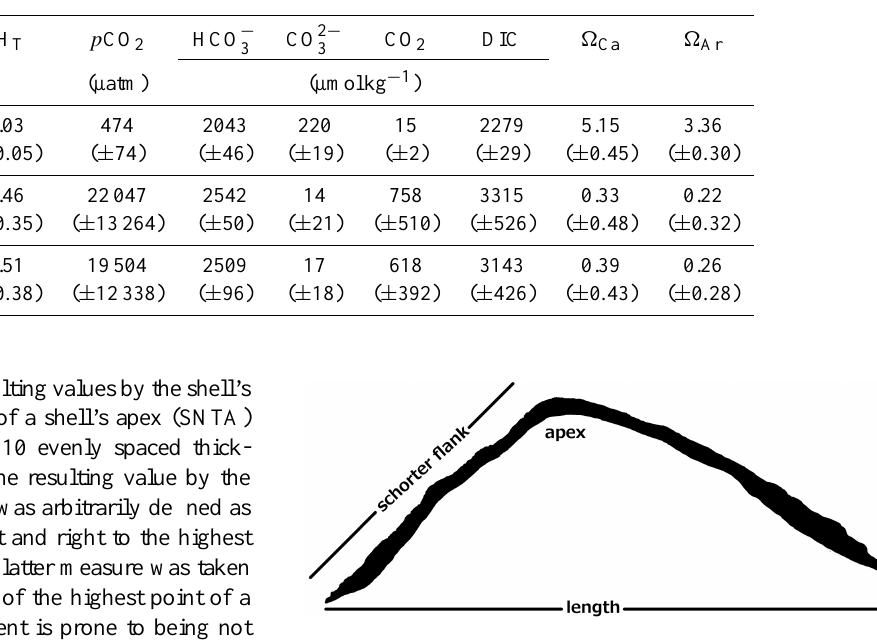
Figure 2. Sketch of a shell indicating length, apex, and shortest flank.